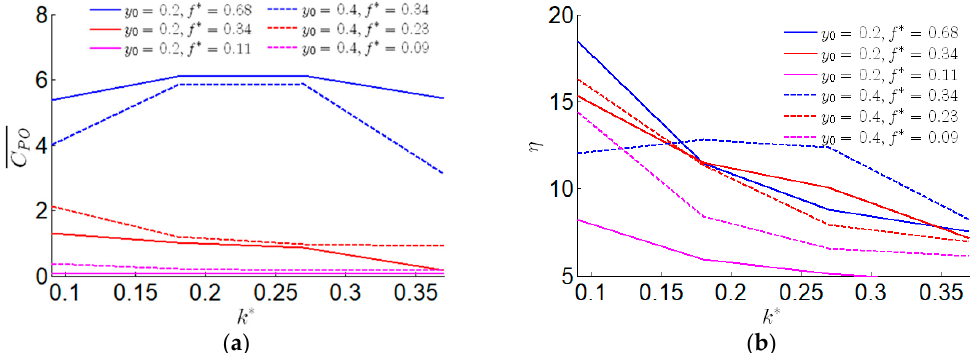
Figure 11. Comparison of (a) the mean value of the output power coefficient and (b) the propulsive efficiency for varying spring stiffness at 𝑦 (cid:2868) = 0.2 − 0.4 , 𝑓 ∗ = 0.09 − 0.68 .